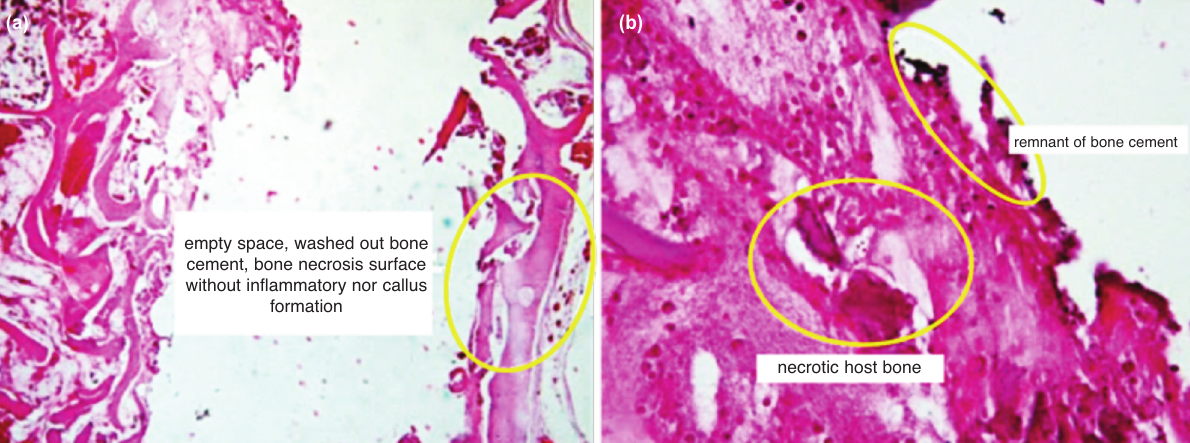
Histology features of the control group (100% PMMA); (a) Empty space from washed out PMMA; the host bone showing absence Fig. 1: of callus formation or inflammatory reaction (5X, HE). (b) Remnant PMMA material along the empty space; host osteonecrosis due to heat of the cement material (20X,